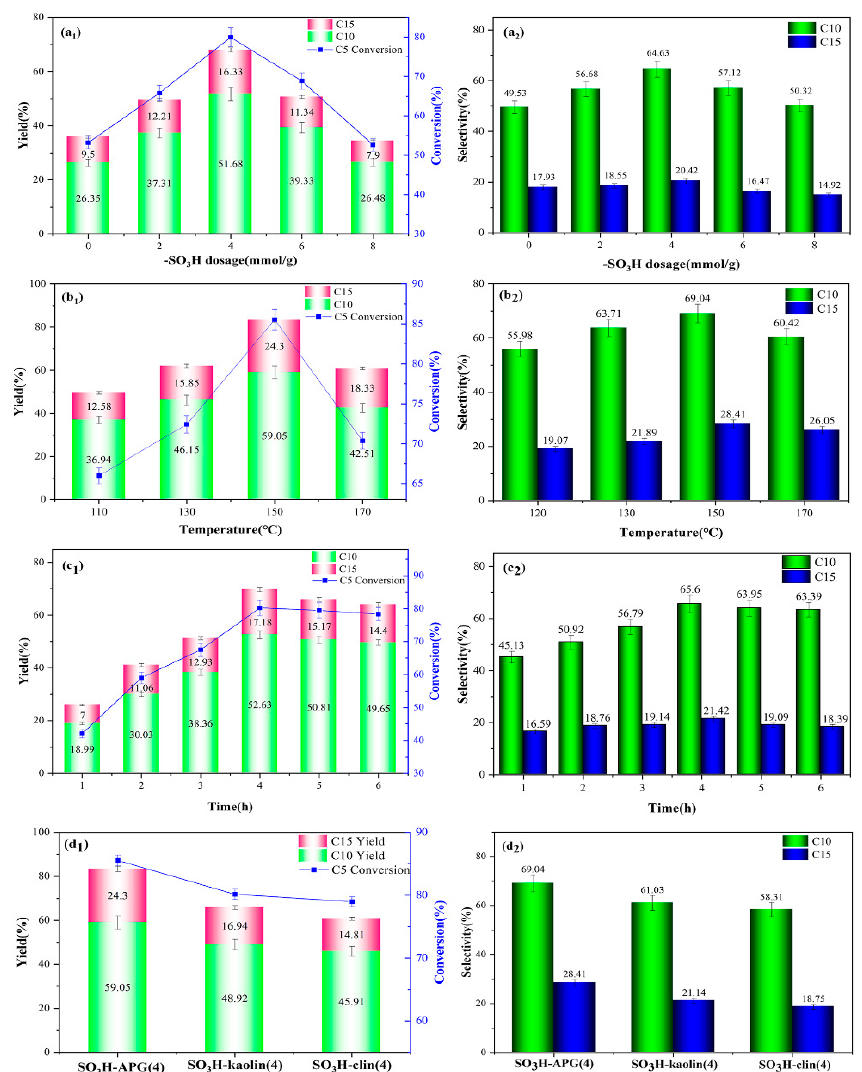
Figure 3. Effect of ( a ) -SO 3 H loading, 150 ◦ C, 4 h; ( b ) reaction temperature, 4 mmol/g, 4 h; ( c ) reaction time, 150 ◦ C, 4 mmol/g; ( d ) catalyst on the condensation reaction of cyclopentanone. Reaction conditions: 0.6 g catalyst, 4 g cyclopentanone, 200 rpm. Letter+1 for yield and letter+2 for selectivity